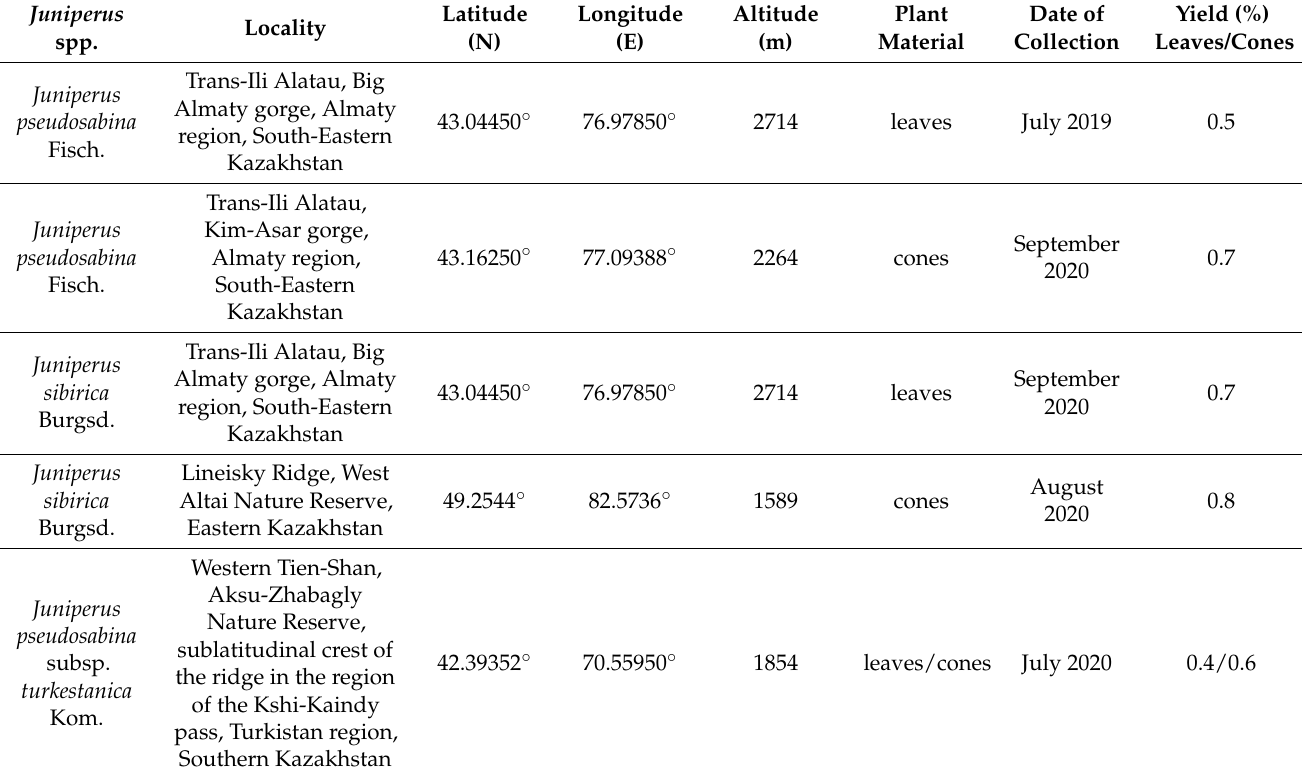
Table 1. Location and date of collection of the plant